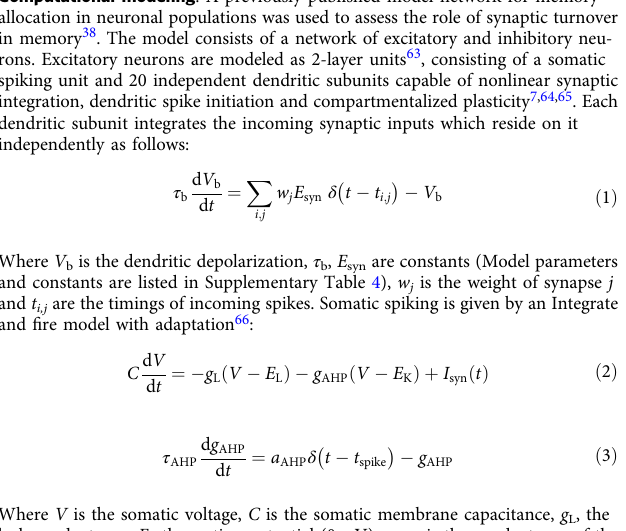
Fig. 4c. For additional details of the model, please see reference 38 . The parameters of the computational model are listed in Supplementary Table 4. Simulation code was written in C++ and is available through the ModelDB